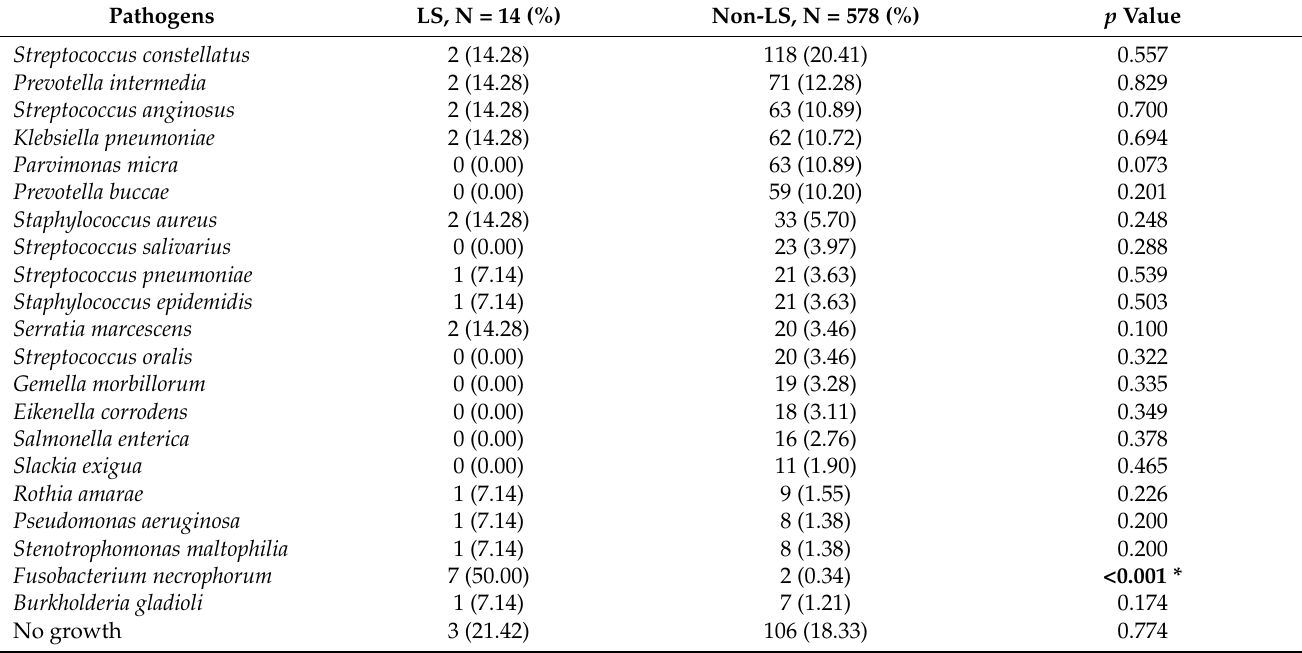
Table 4. Pathogens detected in cultures from 14 patients with concurrent DNI and LS compared with those from 578 patients with DNI